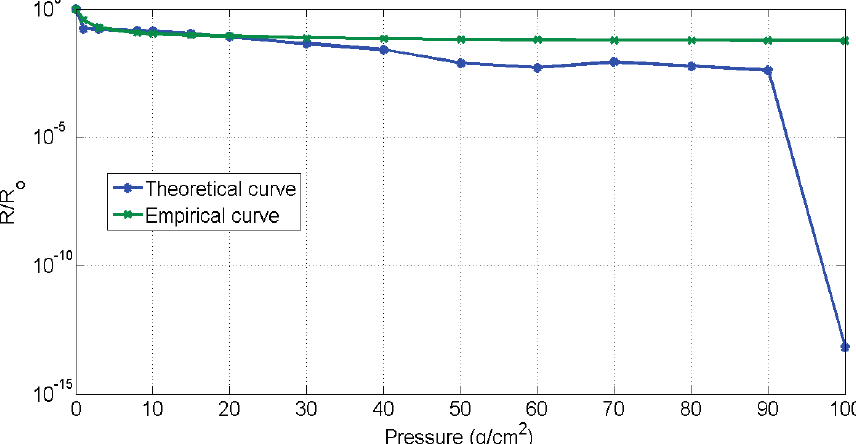
Figure 5. Results validation.